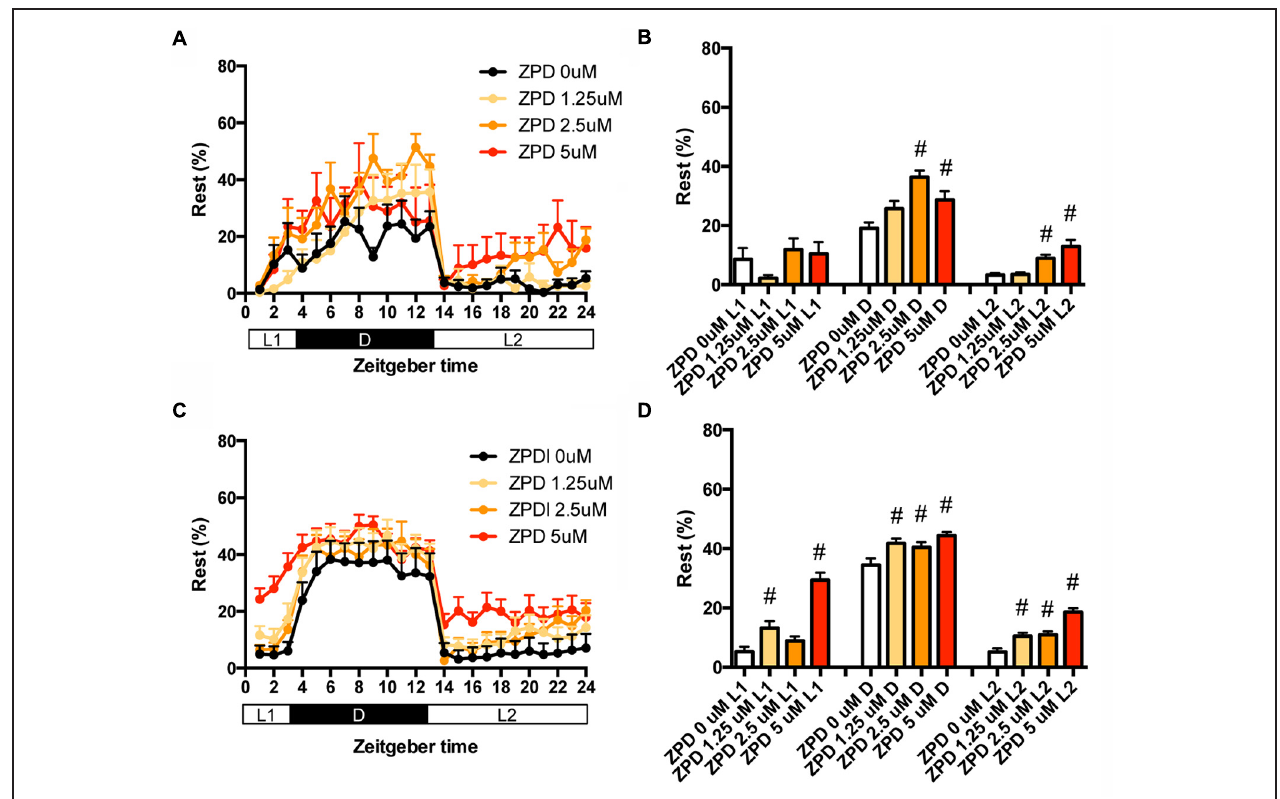
FIGURE 2 | Effects of zolpidem on the rest state of zebrafish from 7 to 8 dpf and 9 to 10 dpf. The rest state of zebrafish treated with zolpidem from 7 to 8 dpf (A) and from 9 to 10 dpf (C) are indicated as percentage of total behavior during each hour. The rest state of zebrafish treated with zolpidem from 7 to 8 dpf (B) and from 9 to 10 dpf (D) are shown as percentage in L1 (ZT 0-3), D (ZT 3-13), and L2 (ZT 13-24). The data are represented as means with the standard error of mean. # p < 0.05 vs.